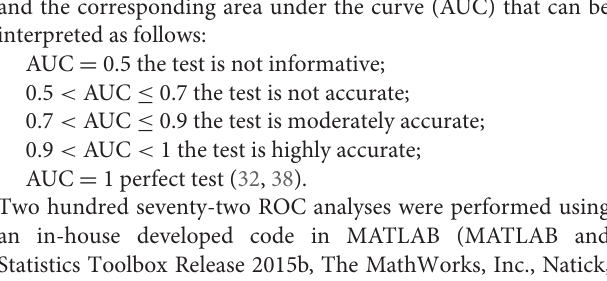
and the corresponding area under the curve (AUC) that can